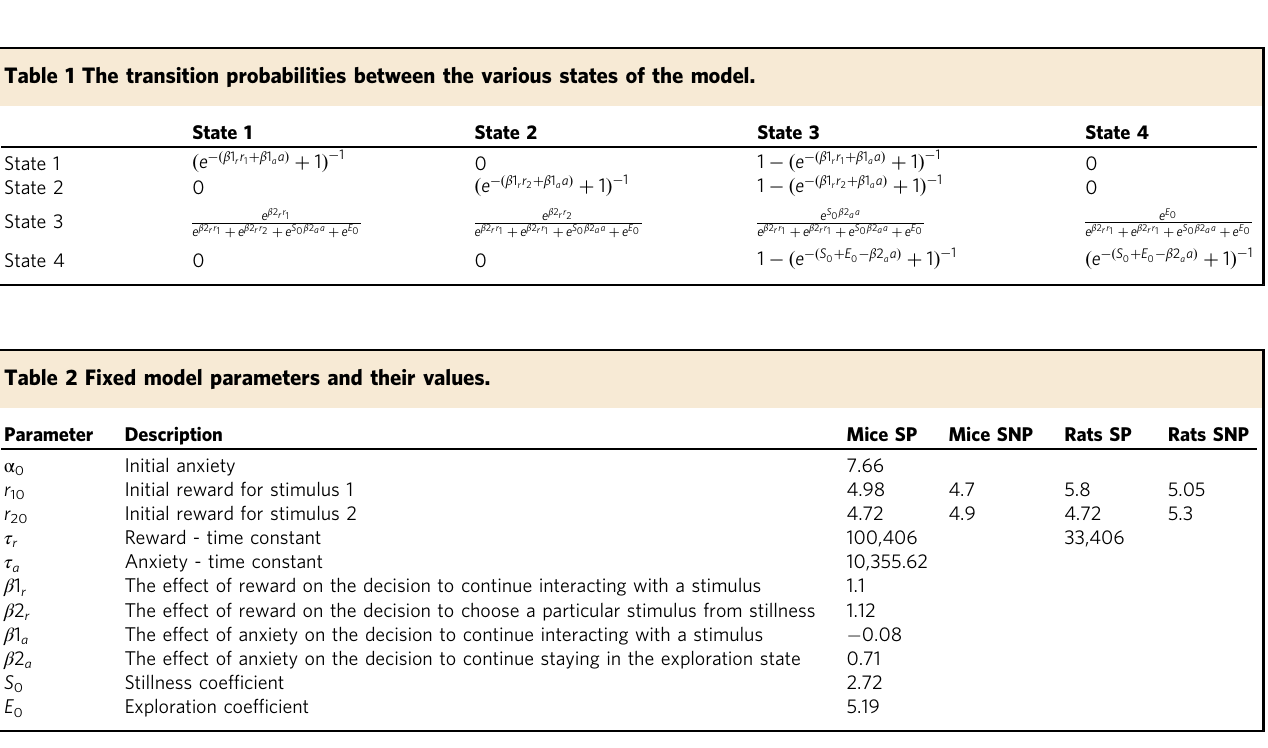
Fig. 8 Behavioral differences between SD rats and C57BL/6J mice are recapitulated by a computational model. a A schematic depiction of a Markov model with four behavioral states used to simulate the behavior of SD rats and C57BL/6J mice in the SP and SNP tests. b A schematic description of how each of the model ’ s probabilities is affected by the various parameters. c The four parameters of the model plotted against time for the SP test in mice. d Mean investigation time (averaged over 20-s bins) for the social and object stimuli, of a simulated random population of 60 mice in the SP test.